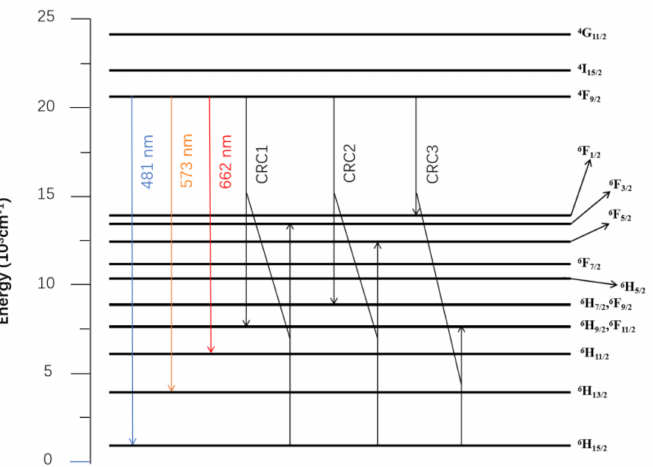
Figure 6. The energy level scheme and the three cross-reaction mechanisms of Dy 3+